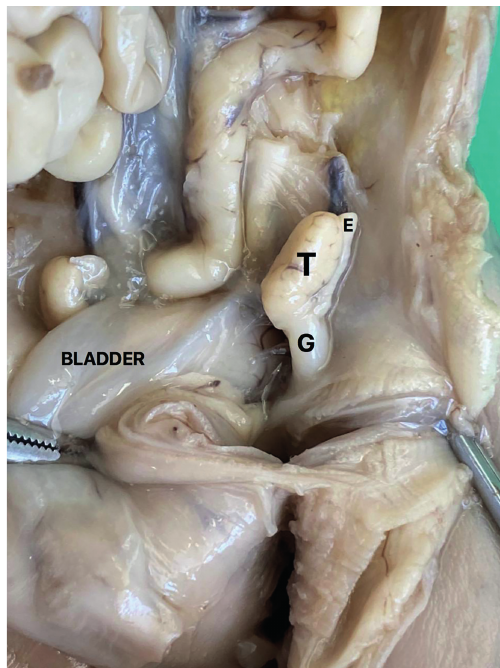
Figure 3 - The figure shows a male fetus with 15 weeks post-conception with both testes situated in the abdomen. The abdominal wall was dissected to show the position of the left testis (T) above the internal ring, G- gubernaculum testis and E-